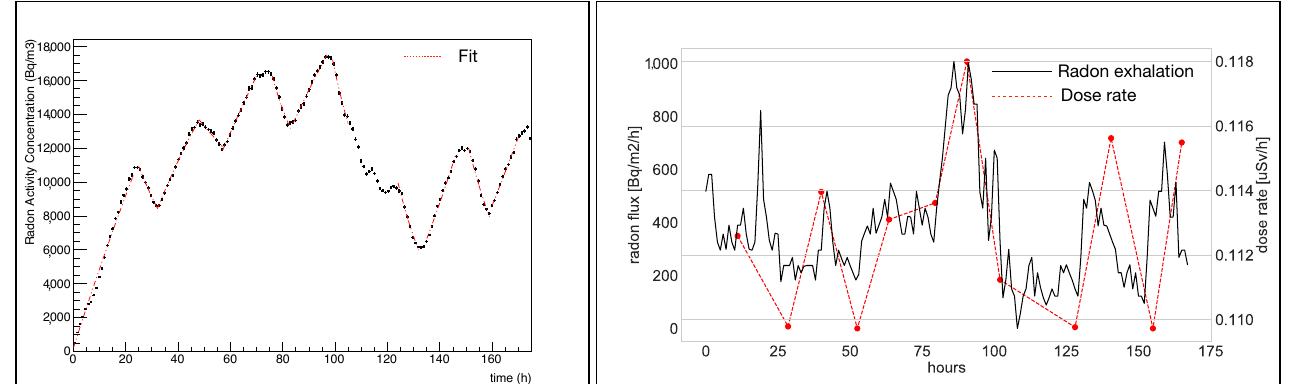
Figure 3. ( Left ) Radon activity concentration in the accumulation chamber (black dots) with the fit results superimposed (red dashed line, color on-line). ( Right ) Superimposition of the radon exhalation flux (red dashed line, color on-line) evaluated using fit results and the simultaneous dose rate measurement results obtained by the Reuter–Stokes (black continuous line).